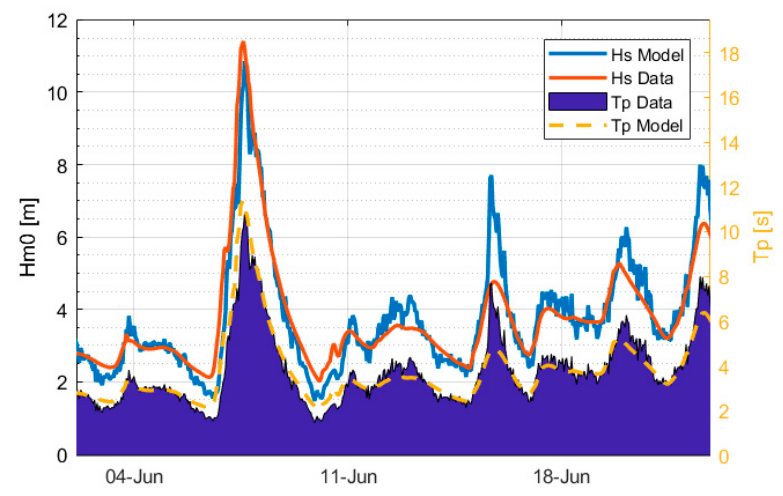
Figure 3. Time series comparison of modelled vs. measured significant wave heights (left axis) and peak periods (right axis) during June 2017 for scenario M3.